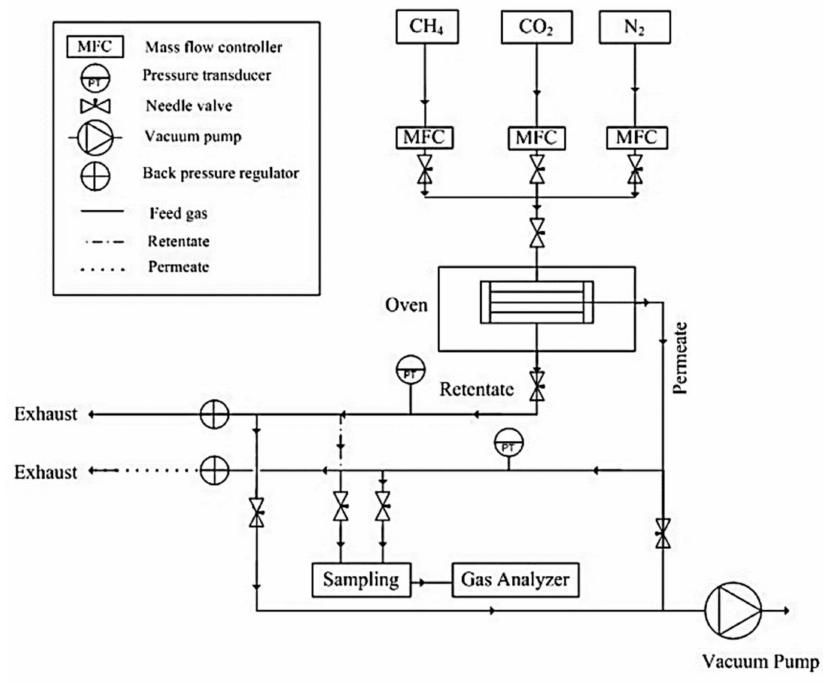
Figure 1. Equipment design for the in-house gas permeation test system used for the experiment